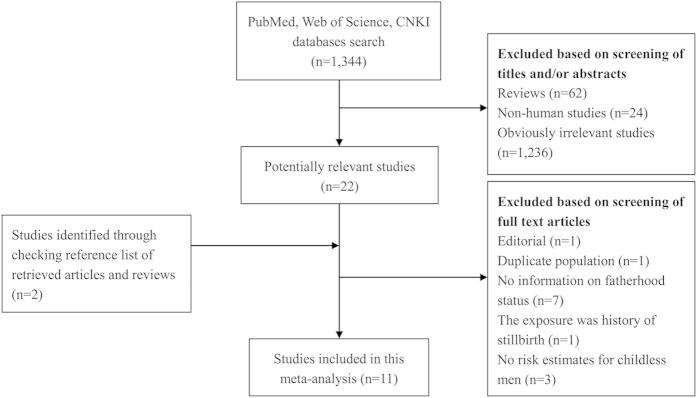
Process of literature search and study selection.